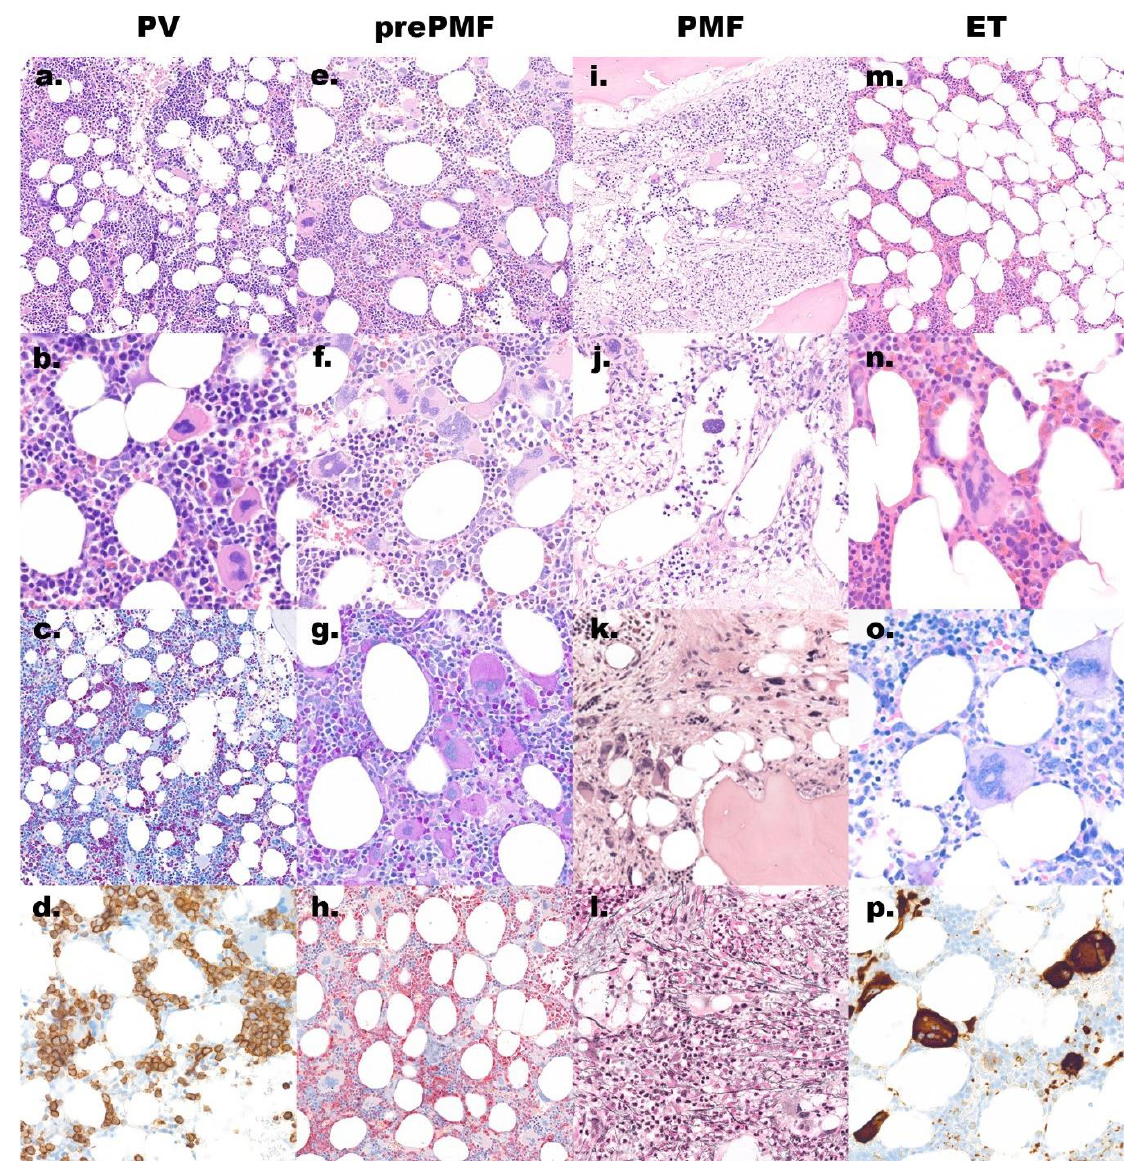
Figure 1. Morphology overview of the main discussed entities. ( a – d ) Polycythemia vera (PV) shows a hypercellular bone marrow biopsy: ( a ) hematoxylin and eosin (H&E) stain, original magnification 200 × ; with increased, morphologically quite variable megakaryocytes: ( b ) H&E stain, original magnification 600 × ; increased erythropoiesis and reduced granulopoiesis: ( c ) naphthol AS-D chloracetate esterase stain, original magnification 200 × ; CD71 marks the increased and left shifted erythropoiesis: ( d ) immunoperoxidase, original magnification 400 × ; ( e – h ) Prefibrotic/early primary myelofibrosis (pre- PMF) shows a hypercellular bone marrow: ( e ) H&E stain, original magnification 200 × ; with increased